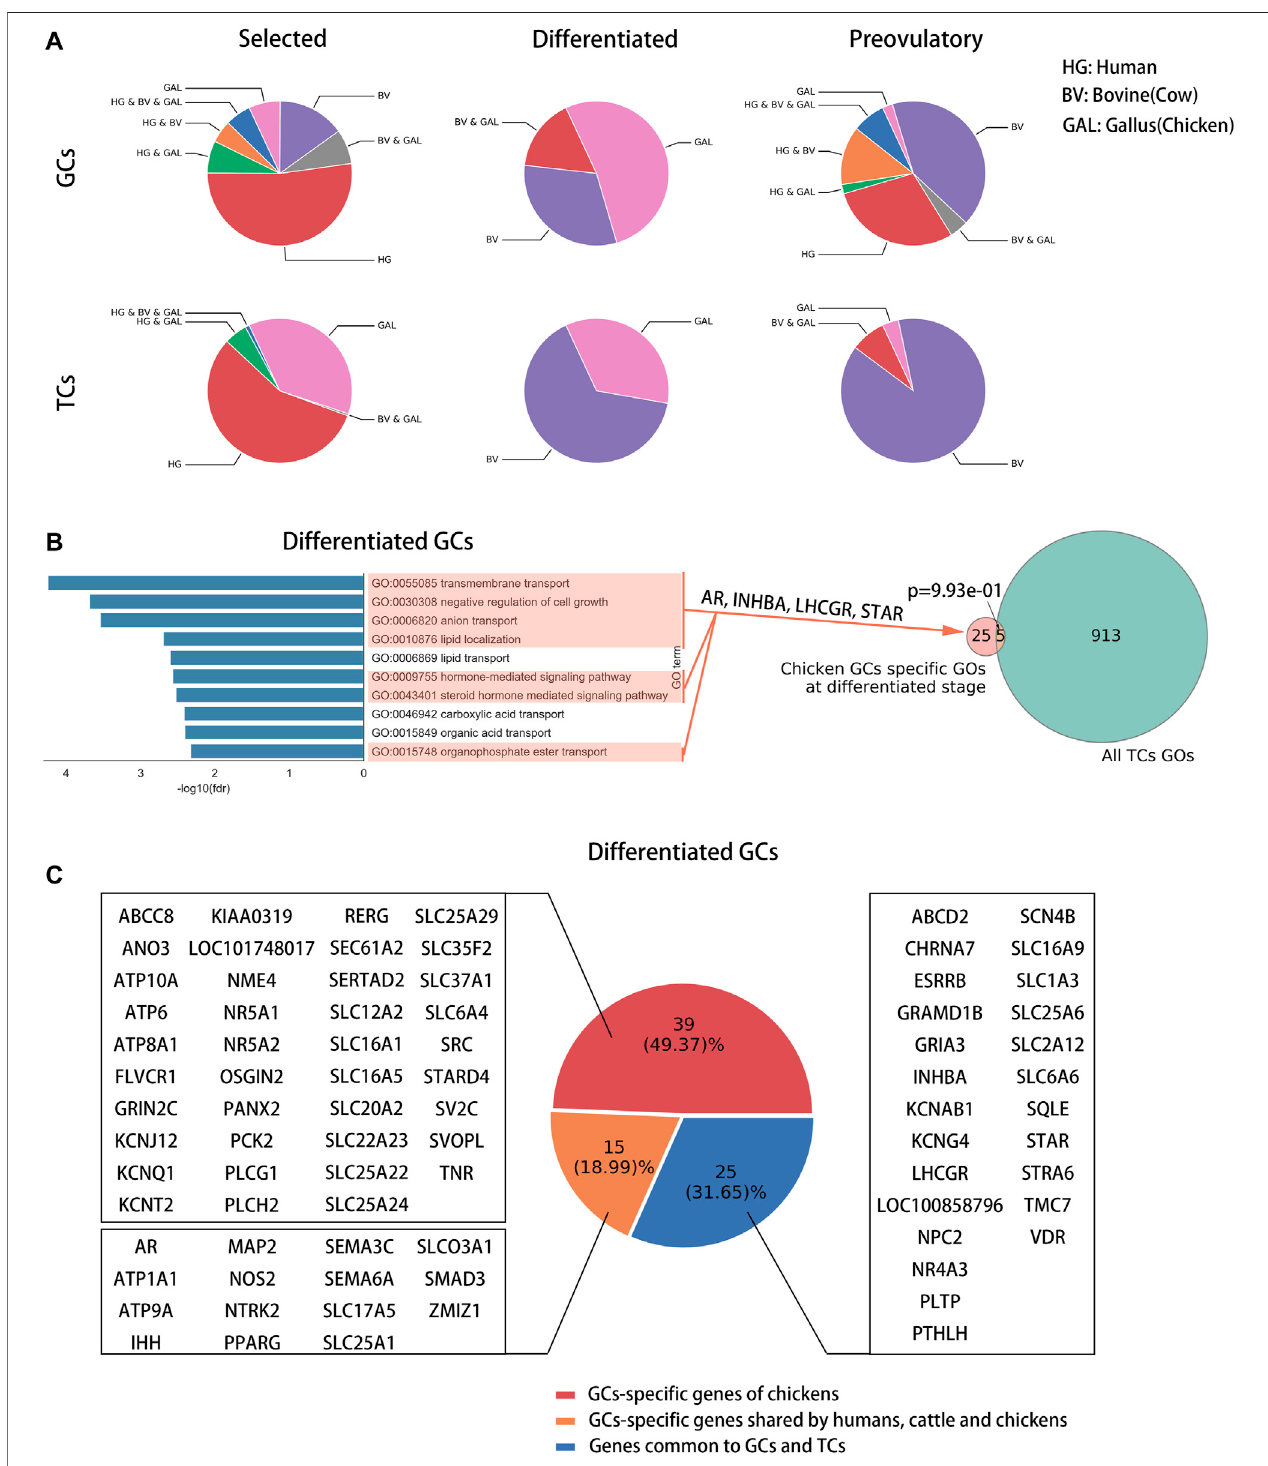
FIGURE 3 | Identi fi cation of follicle development-related genes speci fi c to chickens. (A) Pie charts showing the percentage of follicle development-related BPs at each stage for each species. (B) Candidate chicken-speci fi c BPs in GCs at the differentiated stage. On the left of the graph are the top ten BPs speci fi c to chickens in GCsatthedifferentiatedstage, inwhichcandidatechicken-speci fi cBPsaremarkedinred.OntherightofthegrapharetheVenndiagram showingtheoverlapbetween galBP-diffGCs(red) andallBPsinTCs(green). p wascalculatedusing hypergeometrictest, p ≤ 0.0001.Candidatechicken-speci fi cBPswerefoundonlyingalBP- diffGCs, marked with red arrows, and these BPs were used to identify candidate chicken-speci fi c follicle development-related genes. Previously reported follicle development-related genes are marked with red arrows. (C) Pie chart showing the percentage and corresponding gene names of candidate chicken-speci fi c follicle development-related genes (red) identi fi ed from candidate chicken-speci fi c BPs in galBP-diffGCs.